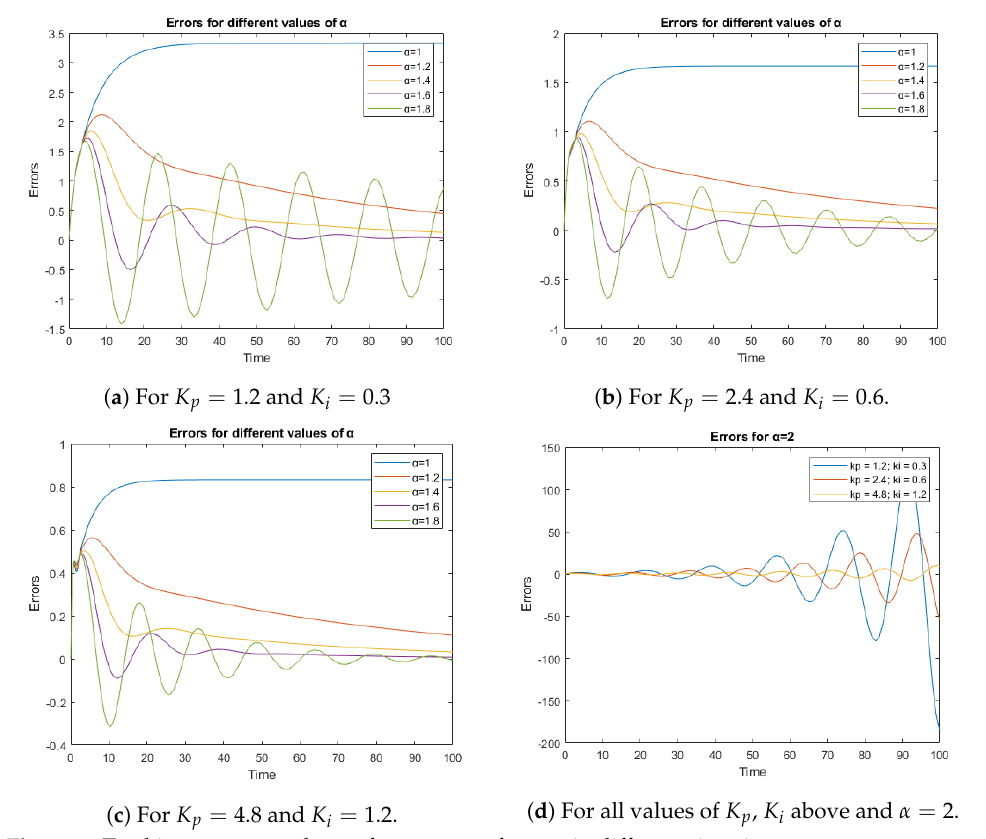
Figure 8. Tracking errors are shown for a ramp reference in different situations. Table 1 shows a stability analysis for some representative cases presented in Figure 8. Table 1. Poles in the first sheet of the Riemann surface for some representative cases presented in the temporal simulations. The case of the last row corresponds to a situation where α = 2.2, which is included to illustrate the presence of poles in the instability